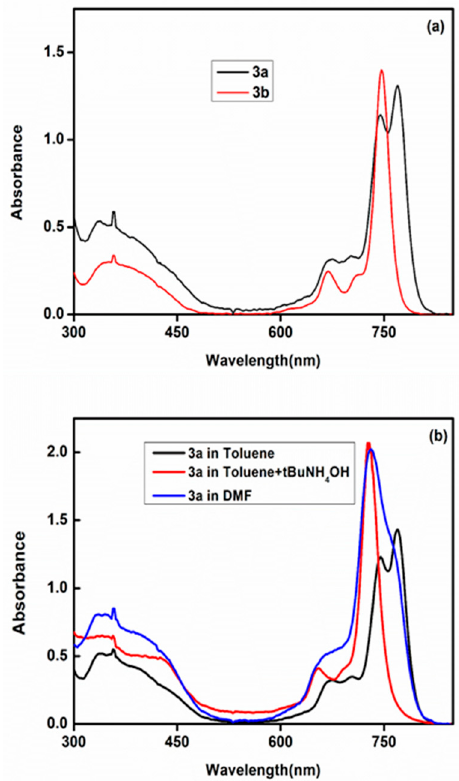
Figure 1. UV-vis absorption spectra of ( a ) 3a and 3b in toluene ( b ) 3a in DMF, toluene and by the addition of tert -butylammoniumhydroxide as a base in the toluene solution.